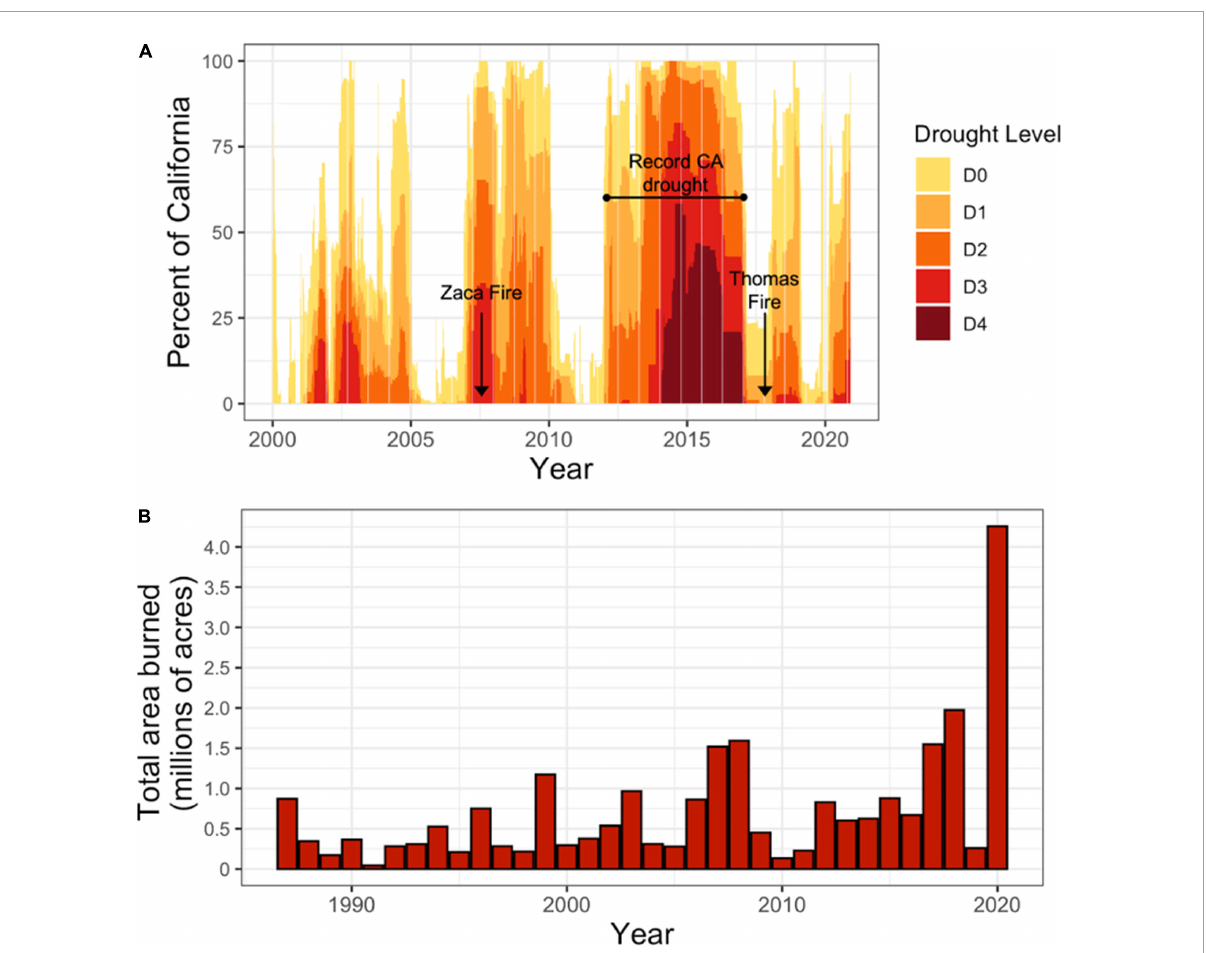
FIGURE1 (A) Timeseries of total land area of California (%) in drought, 2000–2020, with record fires and multiyear drought period indicated. Drought levels: D0 – abnormally dry (short-term dryness slowing planting and growth of crops, some lingering water deficits, pastures or crops not fully recovered); D1 – moderate drought (some damage to crops and pastures, some water shortages developing, voluntary water-use restrictions requested); D2 – severe drought (crop or pasture loss likely, water shortages common, water restrictions imposed); D3 – extreme drought (major crop or pasture losses, widespread water shortages or restrictions); D4 – exceptional drought (exceptional and widespread crop and pasture losses, shortages of water creating water emergencies). Data and drought category definitions from U.S. Drought Monitor (https://droughtmonitor.unl.edu/). (B) Area burned annually (in millions of acres of total land area) by wildfire in California, 1987–2020. 2019 and 2020 reported areas do not include fires under local jurisdiction and therefore may be slightly underreported. 2020 fire data accurate as of December 15, 2020. Data are from CalFire (2020)